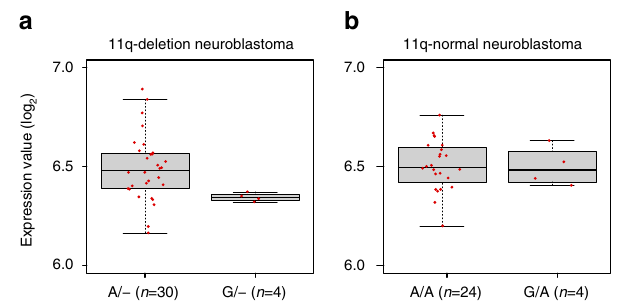
Fig. 2 Box plot of MMP20 mRNA expression levels in neuroblastoma samples with rs10895322 genotypes. a Plot of 34 11q-deletion neuroblastoma samples with rs10895322 genotype A/ − ( n = 30) or G/ − ( n = 4). b Plot of 28 11q-normal neuroblastoma samples with rs10895322 genotype A/A ( n = 24) or G/A ( n = 4). Boxes in boxplots represent fi rst to third quartiles and whiskers extend to furthest data point still within 1.5 IQRs of either quartile. Center lines in boxes